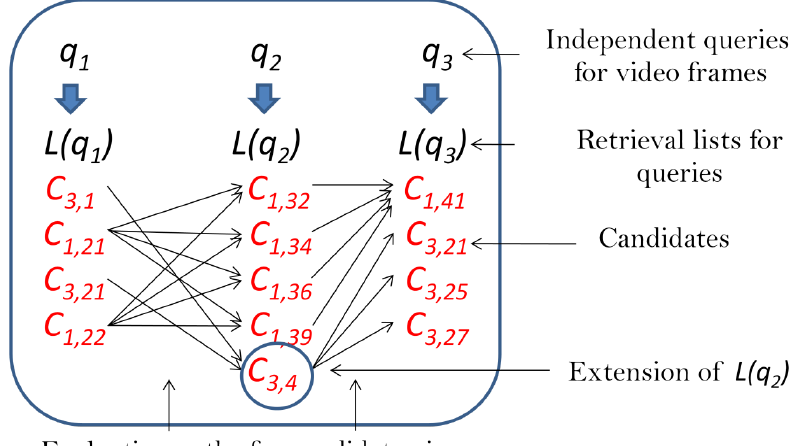
Figure 1. Possible paths defined by candidate objects on the retrieval lists ( N q = 3) to evaluate the Hough score by Equation (4). Note that object c 3 was not on L ( q 2 ) initially, so one of its views was added to be able to obtain its score. Different strategies for this step are discussed in Section